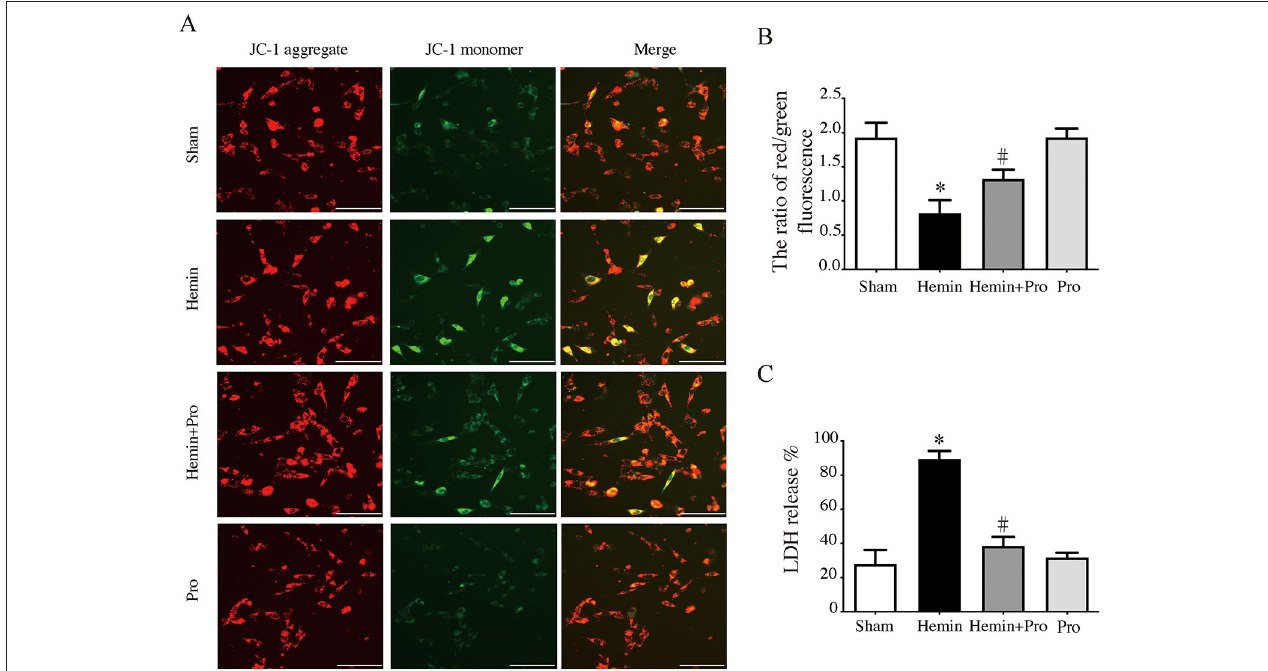
FIGURE 6 | (A) Representative micrographs show JC-1 staining in cultured HT22 cells of sham, hemin, hemin + pro, and pro group. Scale bar = 50 µ m. (B) The ratio of red–green fluorescence in JC-1 staining of sham, hemin, hemin + pro, and pro group. * p < 0.05 vs. sham group, # p < 0.05 vs. hemin group. (C) The release proportion of media lactate dehydrogenase in sham, hemin, hemin + pro, and pro group. * p < 0.05 vs. sham group, # p < 0.05 vs. hemin group.